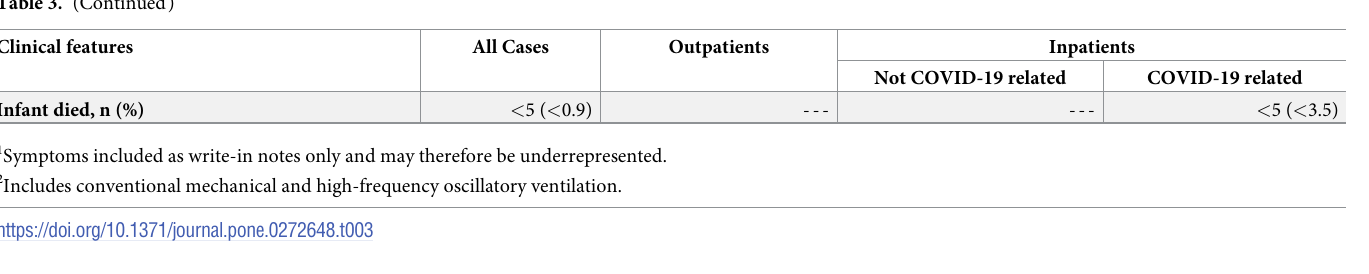
S1 Fig. Odds ratios of COVID-19 admission by continuous infant age, compared to